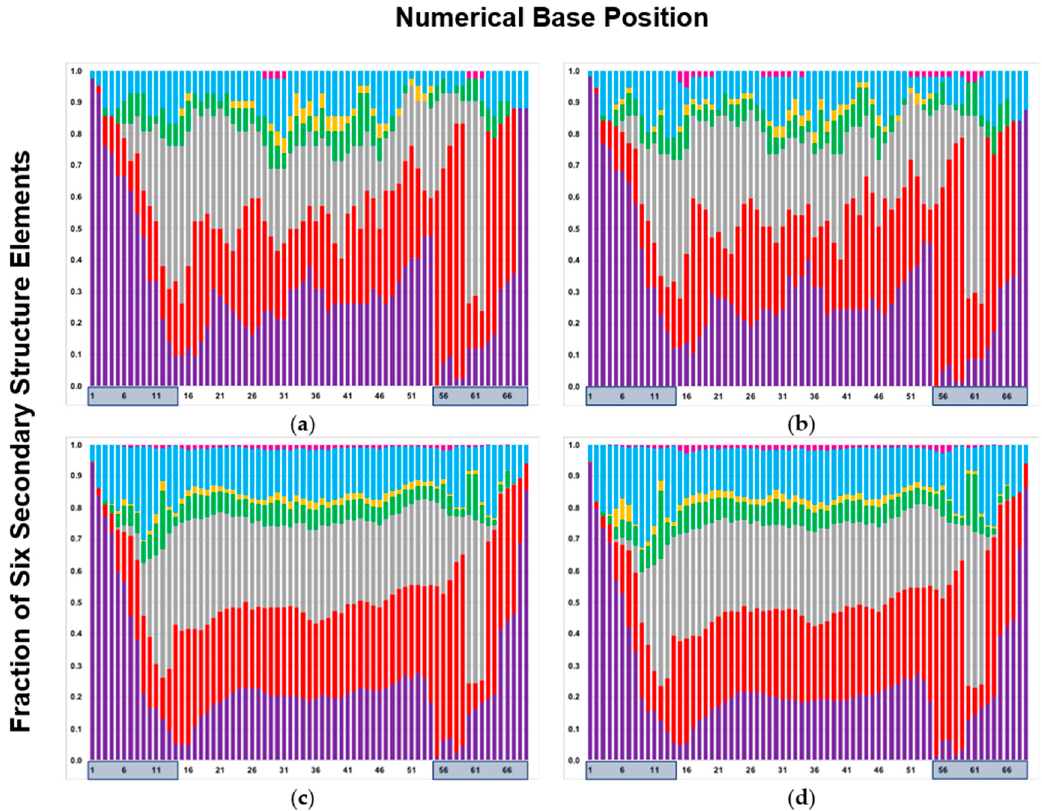
Figure 2. Distribution of secondary structure elements (SSE) as a function of numerical base position for self ‐ hybridized ( a ) dominant ‐ only structures of the aptamers, ( b ) dominant + suboptimal structures of the aptamers, ( c ) dominant ‐ only structures of a random sequence population, and ( d ) dominant + suboptimal structures of a random sequence population. Each bar is color ‐ coded to indicate the relative fraction of multi ‐ branched loops (dark pink); duplexes (blue); bulges (yellow); internal loops (green); hairpin loops (gray); hairpin stems (red); and single ‐ stranded segments (purple) at a given base position. Numerical base positions corresponding to the two fixed base segments are highlighted in gray on each x ‐ axis.